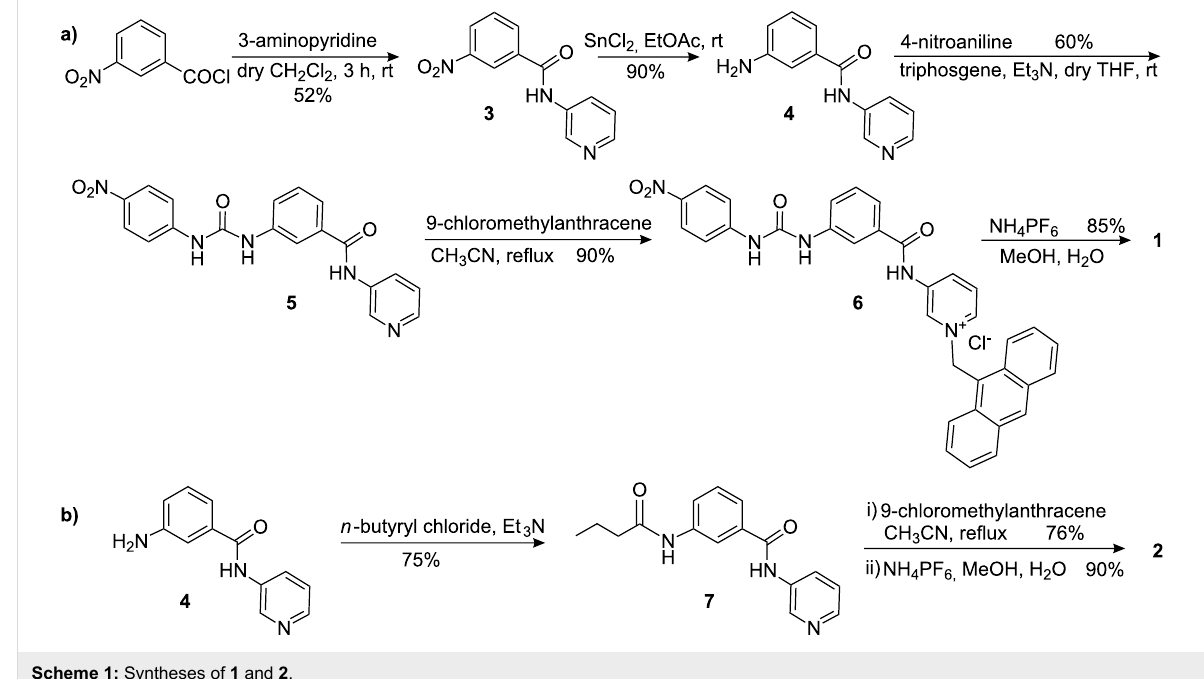
Scheme 1: Syntheses of 1 and 2 .